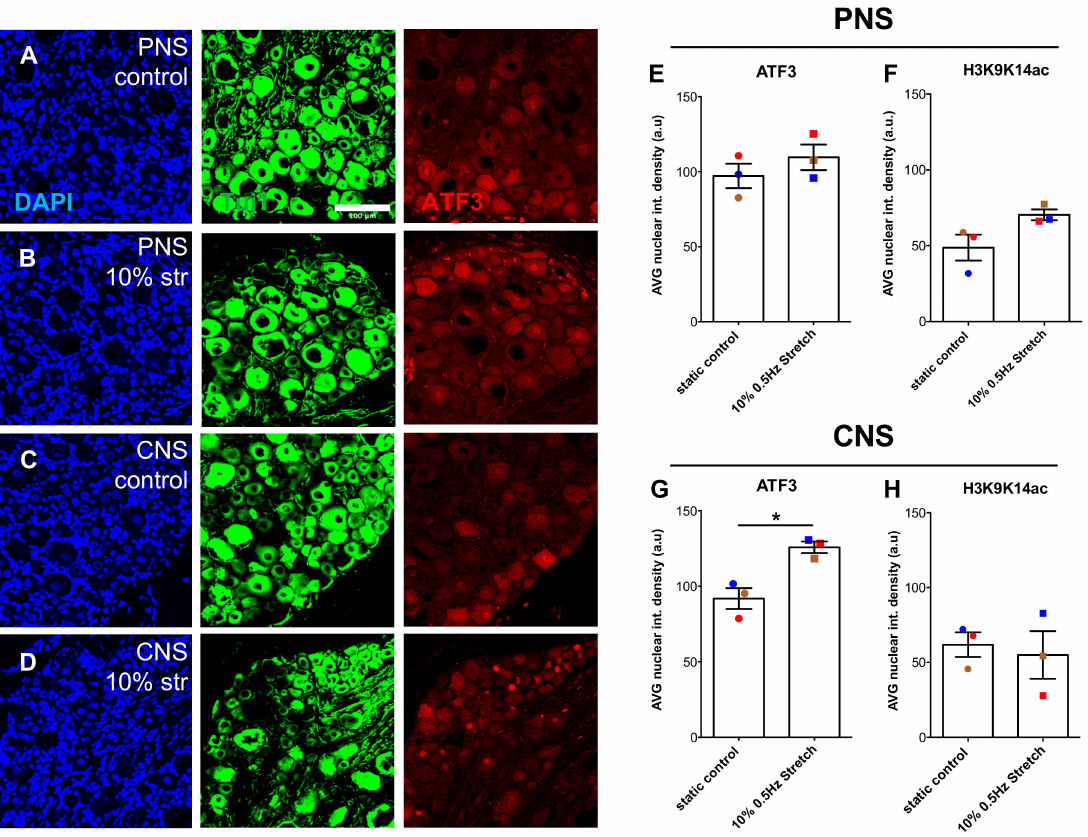
Figure 8. Within 3 h of 10% mechanical stretch, ATF3 nuclear DRG levels increased in the CNS DRG-nerve explant. ( A – D ) Representative immunofluorescence photomicrographs (20 × ) of DRG sectioned either 3 h post- no stimulation ( A ) or 10% mechanical stretch ( B ) of PNS DRG-nerve explants and no stimulation ( C ) or 10% mechanical stretch ( D ) of CNS DRG-nerve explants. DRG were stained for DAPI (blue), β III-tubulin (Tuj1) (green), and ATF3 (red). Scale bar, 100 µ m. ( E , G ) Nuclear intensity density analysis of ATF3 in DRG derived from PNS DRG-nerve explants ( E ) and CNS DRG-nerve explants ( G ). Paired two-tailed Student t -test, mean ± SEM of paired independent experiments indicated by the colors, * p < 0.05. ( F , H ) Nuclear intensity density analysis of H3K9K14ac in DRG derived from PNS DRG-nerve explants ( F ) and CNS DRG-nerve explants ( H ). Paired two-tailed Student t -test, mean ± SEM of paired independent experiments indicated by the